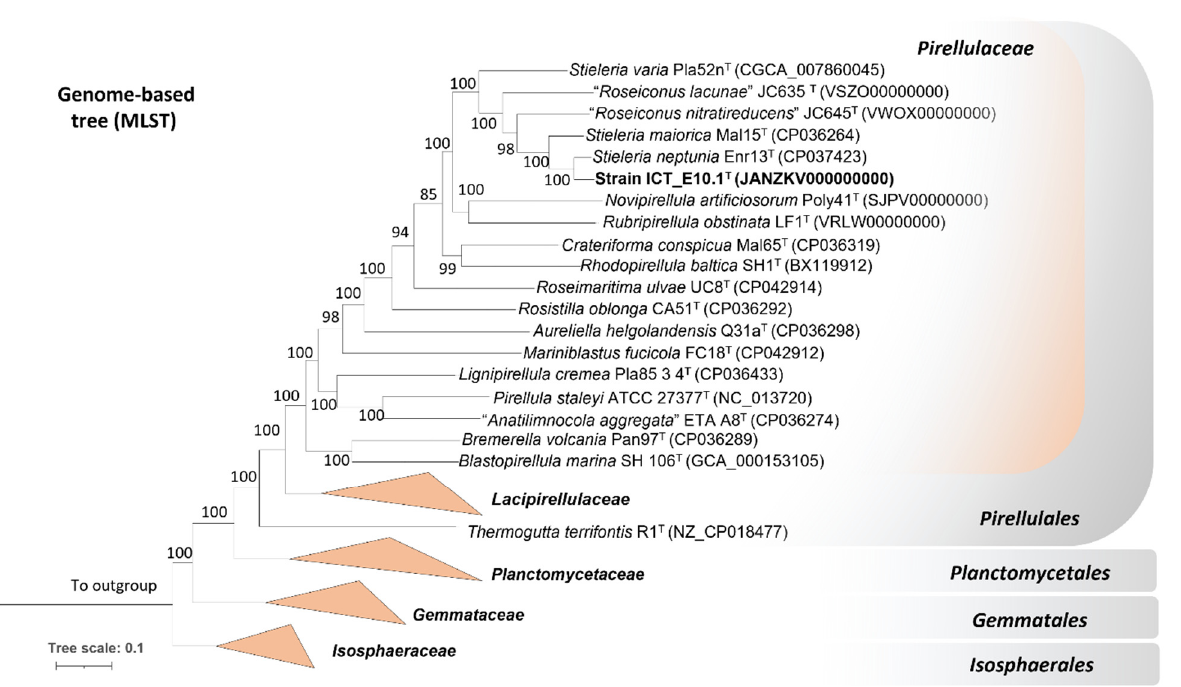
Figure 1. Phylogeny of strain ICT_E10.1 T through the analysis of the 16S rRNA gene sequence. The maximum-likelihood tree evidences the proximity of strain ICT_E10.1 T to the genus Stieleria within the family Pirellulaceae of the bacterial phylum Planctomycetota . GenBank sequence identifiers of other type strains are shown in parentheses. One thousand bootstraps were applied, and the respective values given at the nodes (in %). Branches of the other families in the class Planctomycetia collapsed at the family level. Three strains from the phylum Verrucomicrobiota were utilized as outgroups .